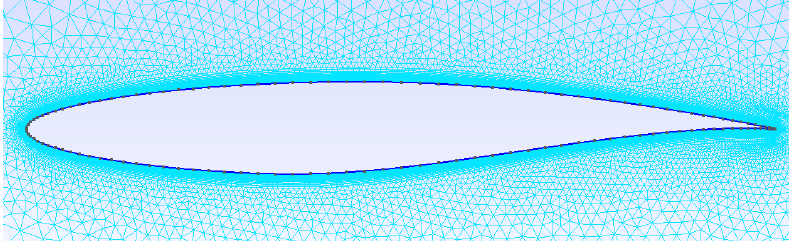
Figure 5. Detailed view of the refinement near the airfoil